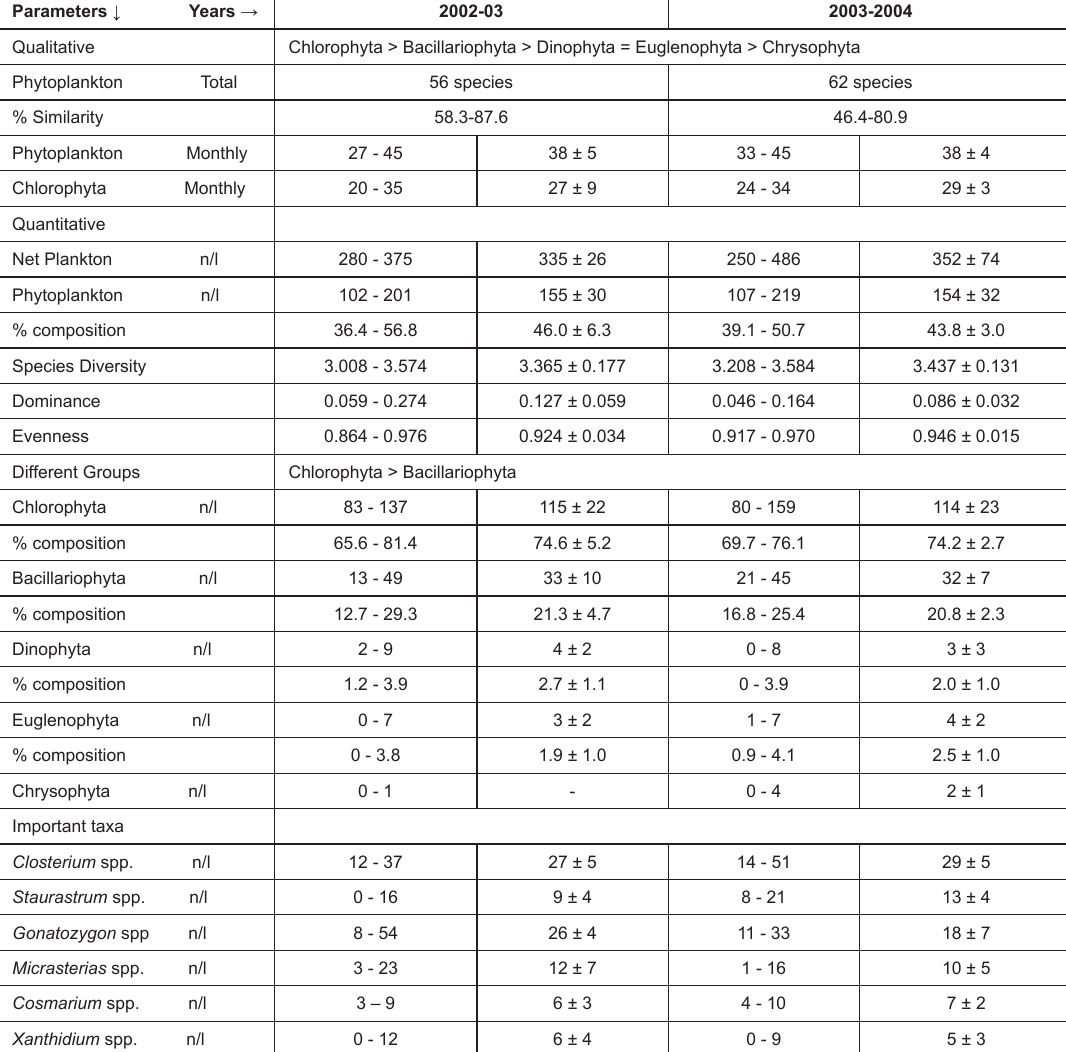
Table 2. Temporal variations of phytoplankton at Utra